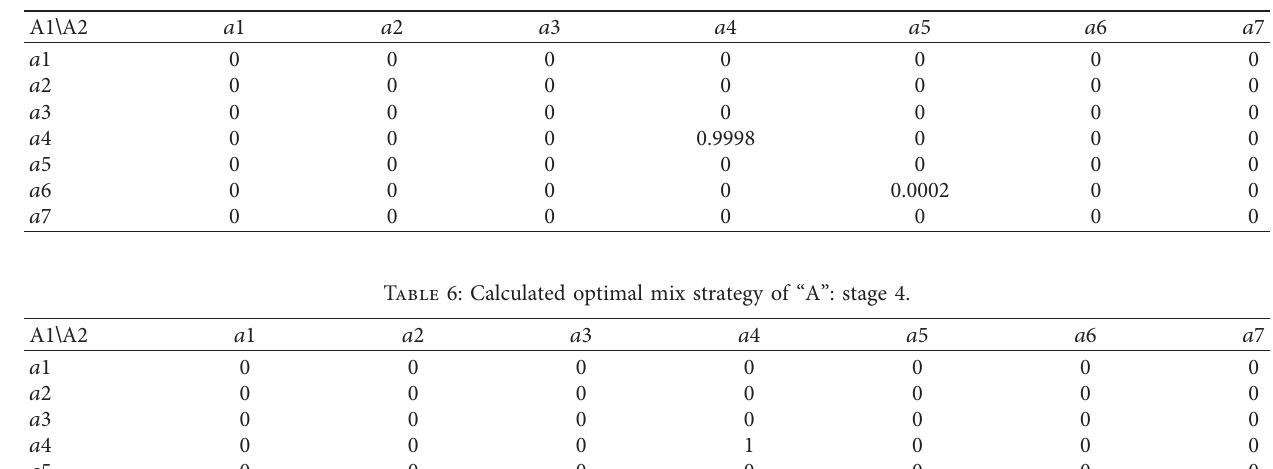
Table 5: Calculated optimal mix strategy of “A”: stage 3.